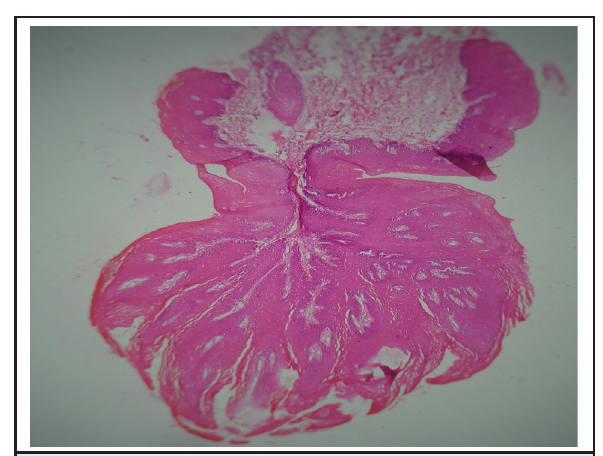
Figure 5. Histopathological photograph showing (cid:74)(cid:91)(cid:82)(cid:71)(cid:84)(cid:82)(cid:67)(cid:84)(cid:67)(cid:77)(cid:71)(cid:84)(cid:67)(cid:86)(cid:75)(cid:80)(cid:75)(cid:92)(cid:71)(cid:70)(cid:2)(cid:85)(cid:86)(cid:84)(cid:67)(cid:86)(cid:75)(cid:383)(cid:71)(cid:70)(cid:2)(cid:85)(cid:83)(cid:87)(cid:67)(cid:79)(cid:81)(cid:87)(cid:85)(cid:2)(cid:71)(cid:82)(cid:75)(cid:86)(cid:74)(cid:71)(cid:78)(cid:75)(cid:87)(cid:79)(cid:2) forming papillary projection.